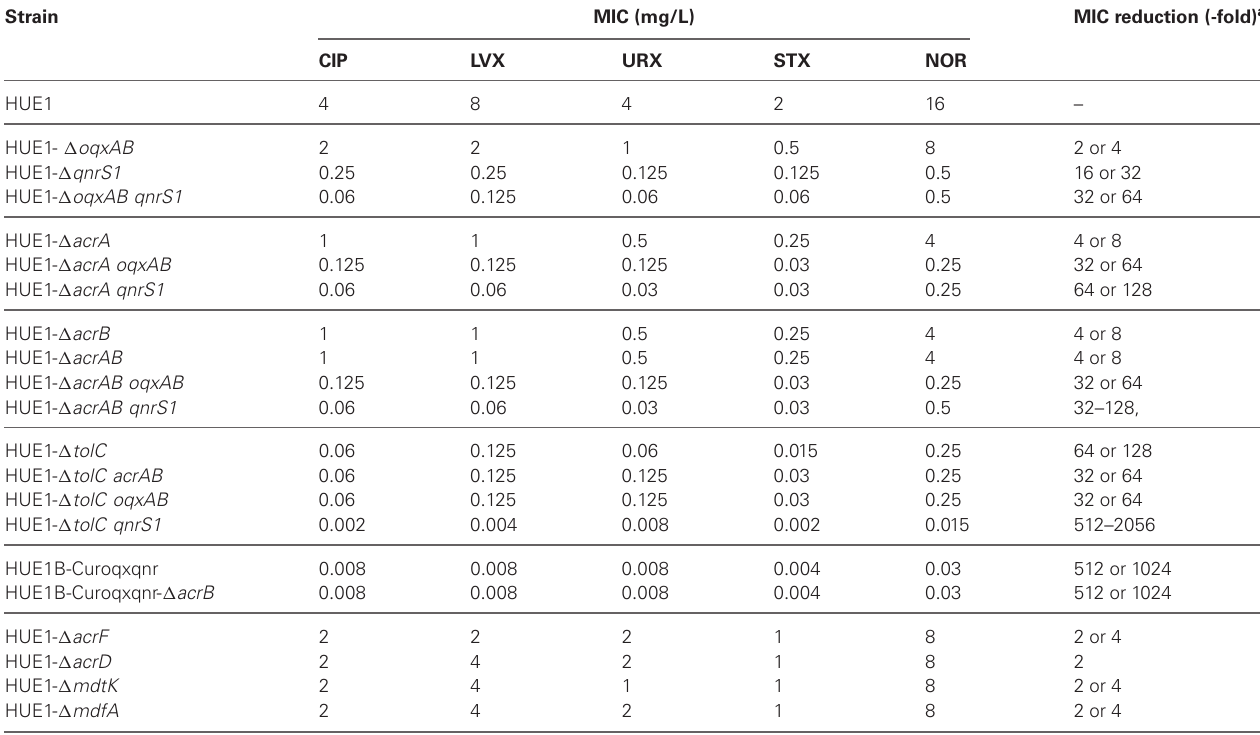
Table 5 | Fluoroquinolones susceptibilities of Red/ET recombination mutants derived from HUE1.